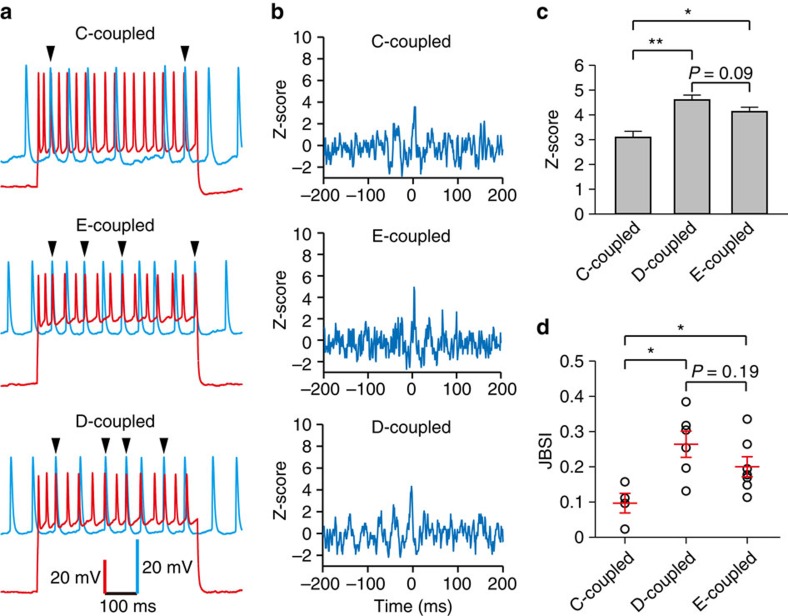
The effect of bidirectional chemical synapse in controlling firing synchrony between layer 1 interneurons.To test for firing synchrony in three interneuron groups (C-coupled, E-coupled and D-coupled), paired spike trains were elicited by suprathreshold current in the driver cell (red traces, 30–50 Hz) and by tonic suprathreshold depolarization in the follower cell (blue traces, ∼10 Hz), respectively. (a) Sample traces of paired spike trains from two neurons coupled by different patterns of connectivity in neocortical layer 1, the arrowheads indicate the synchronous spikes. (b) Normalized cross-correlogram (Z-score) for neuron pairs in (a). Bin size is 2 ms. Note that the cross-correlogram exhibited a peak ∼0 ms in all three groups. (c) Average Z-scores for different patterns of connectivity. Note that Z-scores of E- and D-coupled pairs were significantly higher than that of C-coupled pairs, and Z-scores of D-coupled pairs were slightly lower than that of E-coupled pairs. (d) Average JBSI values for different patterns of connectivity. C-coupled pairs=4, E-coupled pairs=6, D-coupled pairs=7, from 10 mice. *P<0.05, **P<0.01, two-tailed paired t-test. Error bars represent mean±s.e.m.